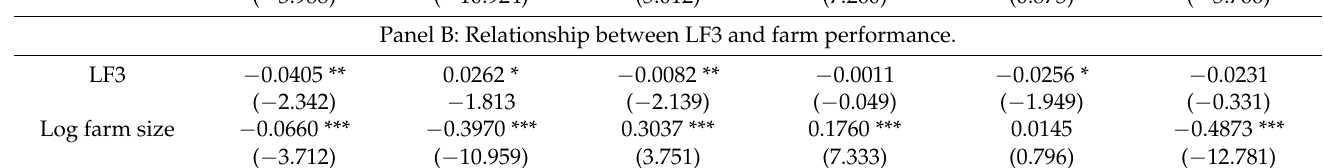
Table 12. Robust check of LF2 and LF3 on farm performance. Material Cost Labour Cost Panel A: Relationship between LF2 and farm performance.